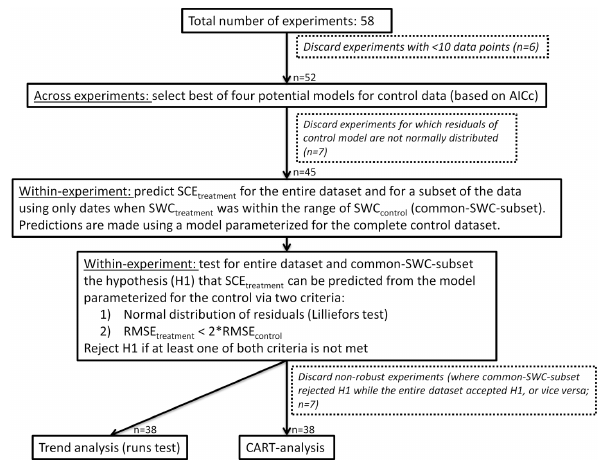
Figure 2. Protocol of the analyses performed to test the hypothesis (H1) that the moisture response of soil CO 2 efflux as observed in the control plots (SCE control ) can be used to predict soil CO 2 efflux in the precipitation manipulation treatment (SCE treatment ) . The num- ber of sites for each step and the reasons for discarding experiments from further analyses are